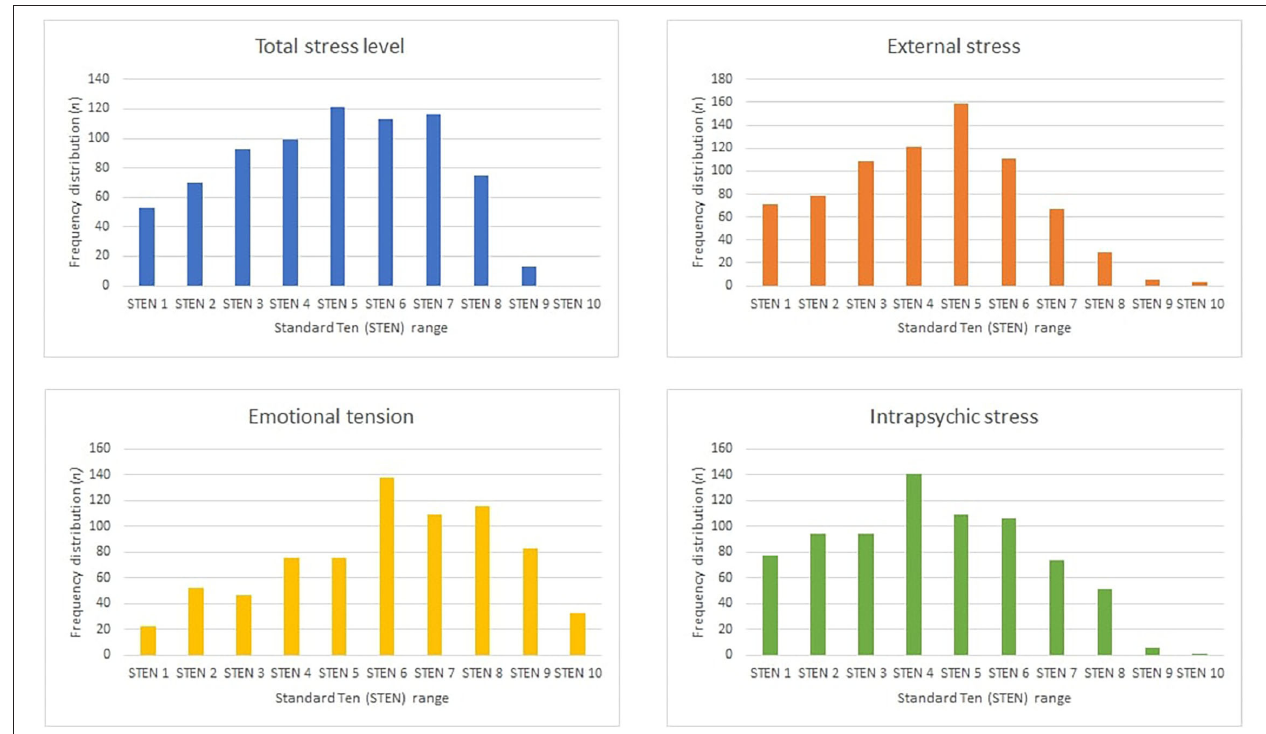
FIGURE 1 | Distribution of the respondents in the respective